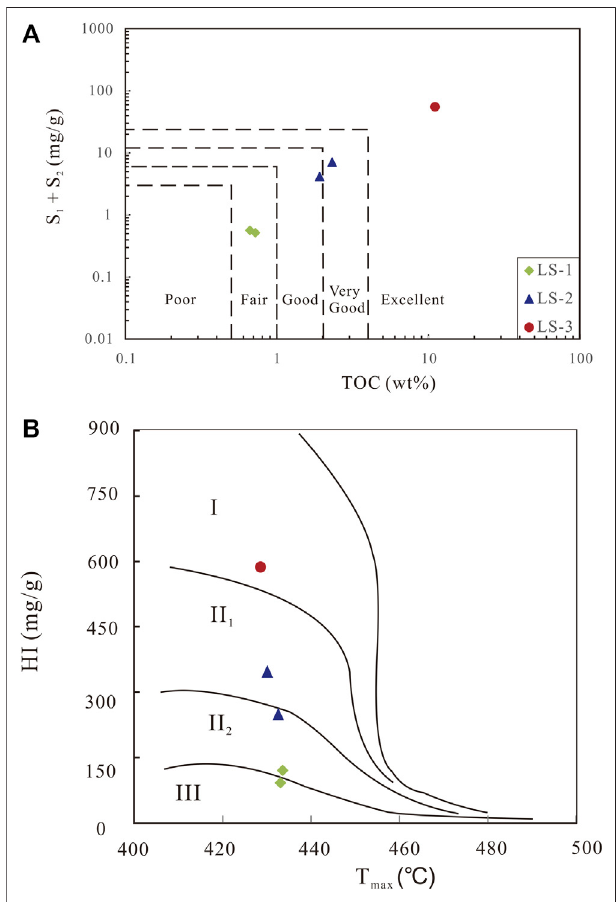
FIGURE3| Crossplots of (A) Rock-Eval S 1 +S 2 vs. totalorganic carbon (TOC)and (B) hydrogenindexvs.T max forthestudiedpotentialsourcerocksin the Liushagang Formation. LS-1 = fi rst member of the Liushagang Formation; LS-2 = second member of the Liushagang Formation; LS-3 = third memberoftheLiushagangFormation.Thecriteriadistinguishpoor,fair,good, very good and excellent source rock are from (Peters and Cassa,